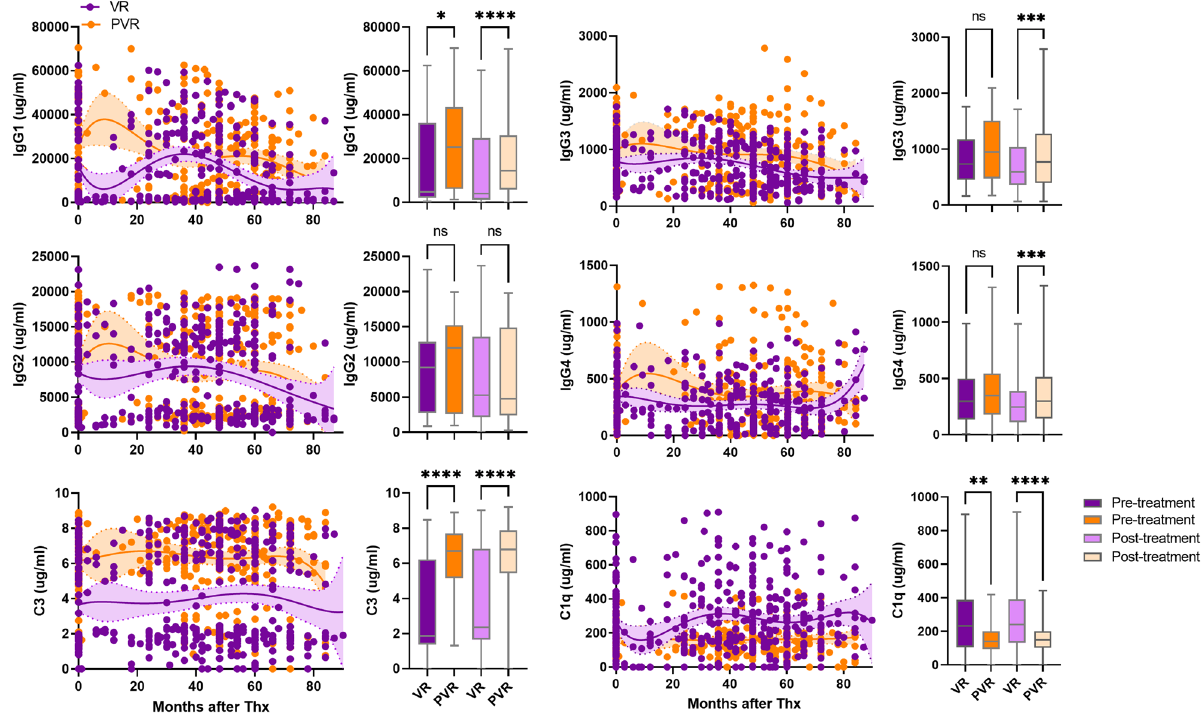
Figure 3. Levels of IgG subtypes and complement C3 and C1q in serum of CHB patients with virological response (VR) and partial virological response (PVR) patients. Serum levels of IgG1–4, complement C3, and C1q were measured in VR patients (n = 70, purple dots) and PVR patients (n = 56, orange dots). Shaded areas indicate 95% confidence intervals around the regression lines. Bar graphs represent concentration of IgG1-4, complement C3 and C1q in pre-treatment (dark purple), post-treatment (light purple) of VR and pre-treatment (dark orange), post-treatment (light orange) of PVR patients. *p ≤ 0.05, **p ≤ 0.01, ***p ≤ 0.001, ****p ≤